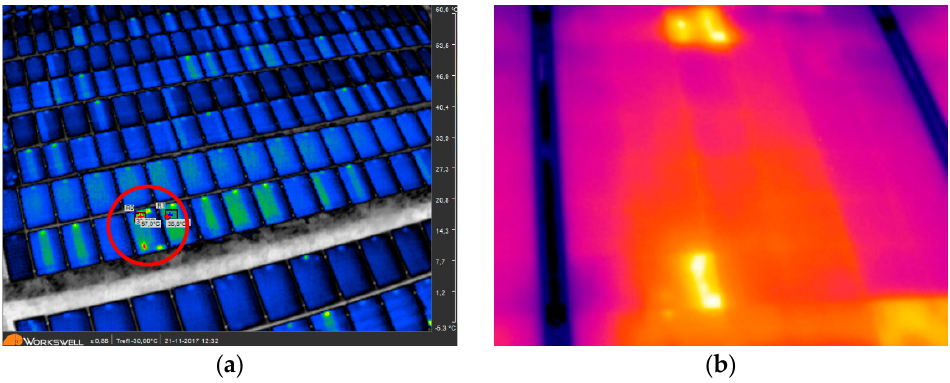
Figure 5. Thermographic analysis for an incident of broken glass: ( a ) aerial IR inspection, and ( b ) ground-level IR inspection. The red circle in ( a ) identifies the affected PV module.